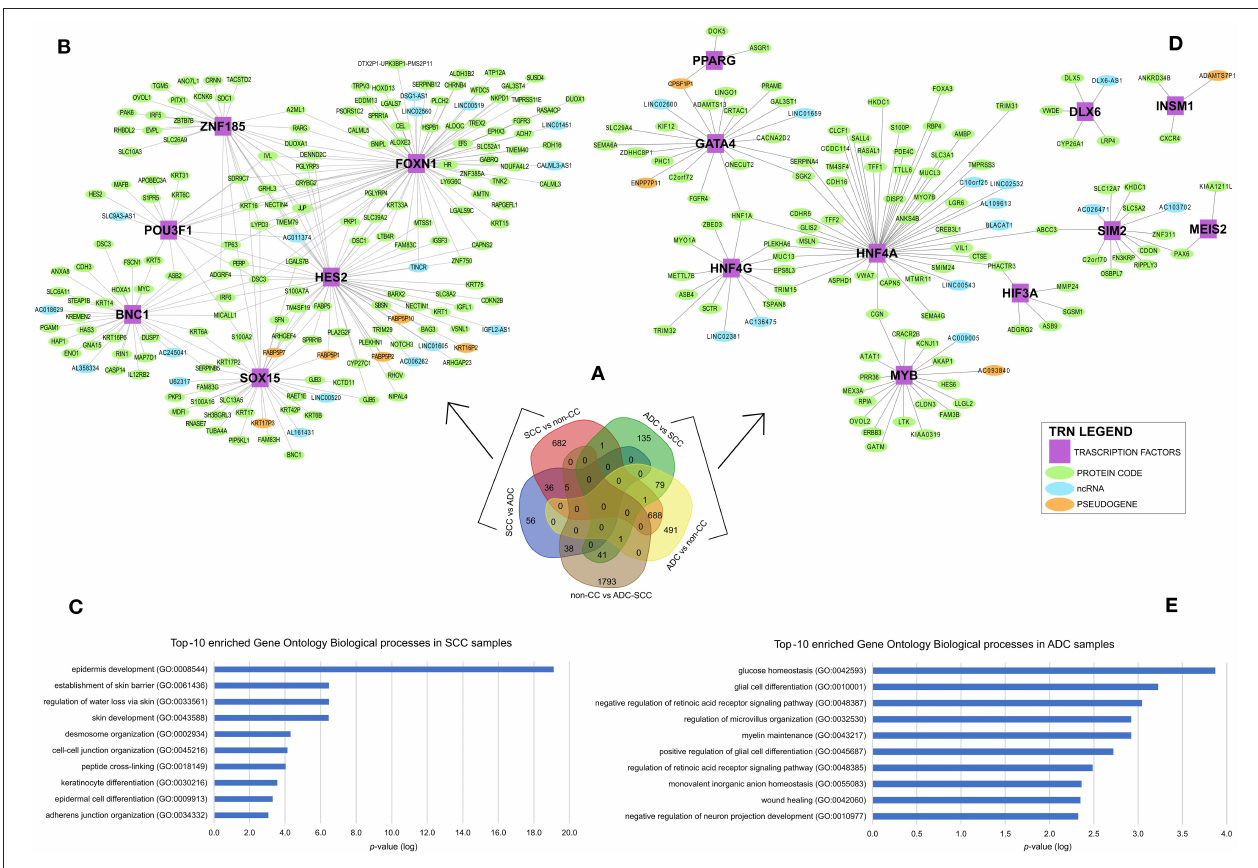
FIGURE 2 | Differential gene expression profiles among cervical squamous cell carcinomas (SCC), cervical adenocarcinomas (ADC), and non-tumoral cervical tissue and HPV-negative (non-CC) samples. (A) Number of genes differentially expressed in each group. Transcription regulatory networks (TRN) of genes upregulated in SCC (B) and ADC (D) , including transcription factors (purple squared), other protein-coding genes (green circle), long non-coding RNAs (lncRNA) (light blue circle), and pseudogenes (light orange circle). Ten most enriched Gene Ontology Biological processes involved in cervical SCC (C) and ADC (E) TRNs. Biological processes were grouped by enriched Gene Ontology (GO) Biological processes (y-axis) and sorted by lower logarithm scale of p- values (x-axis, p < 0.05), calculated by Enrichr